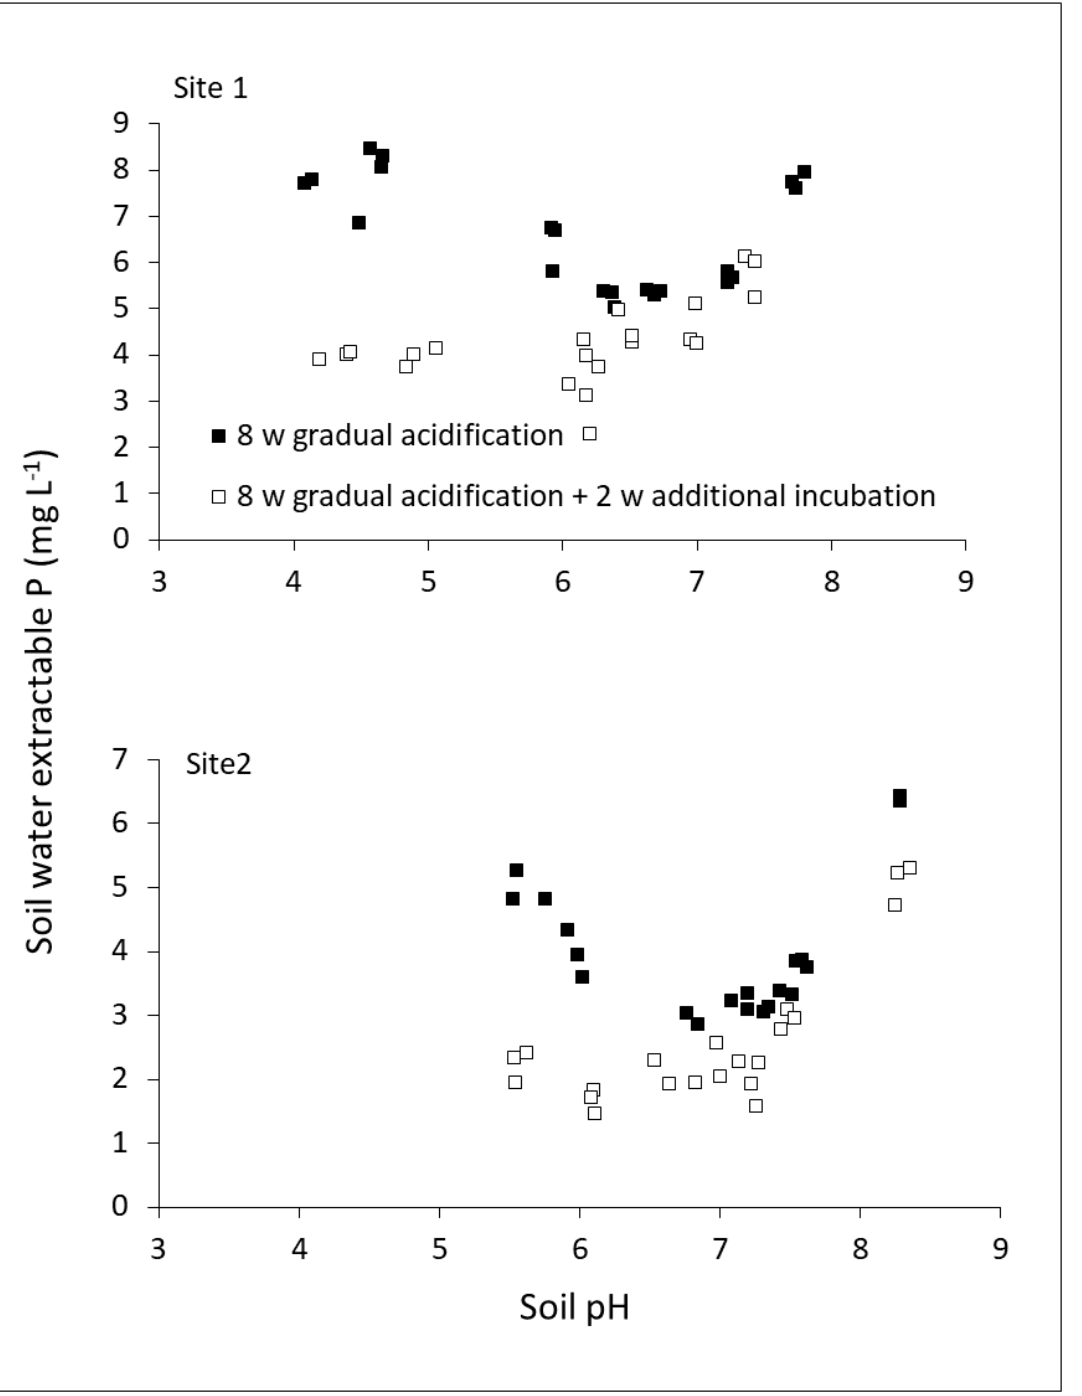
Figure 4. Relationship between soil pH and water extractable phosphorus (P) among soils gradually acidified for 8 weeks (8 w) compared to the same soils incubated for 2 further weeks ( + 2 w) without receiving any additional acidification. Soils at both sites were a Lindside silt loam. Adapted from Penn and Bryant [74].